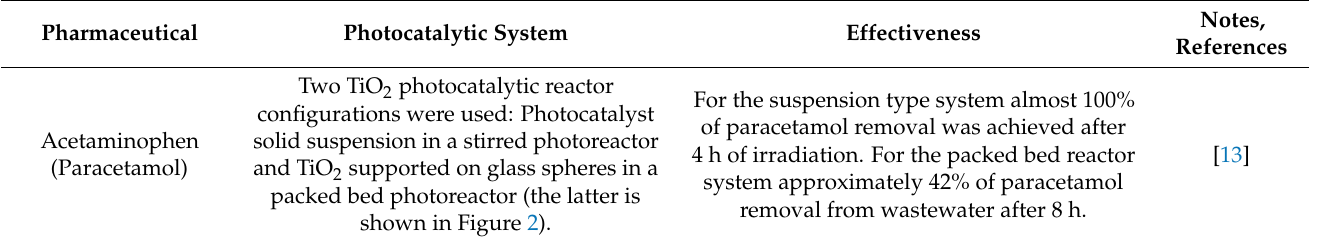
Table 2. Selected Examples of Pharmaceutical Removal Using Heterogeneous